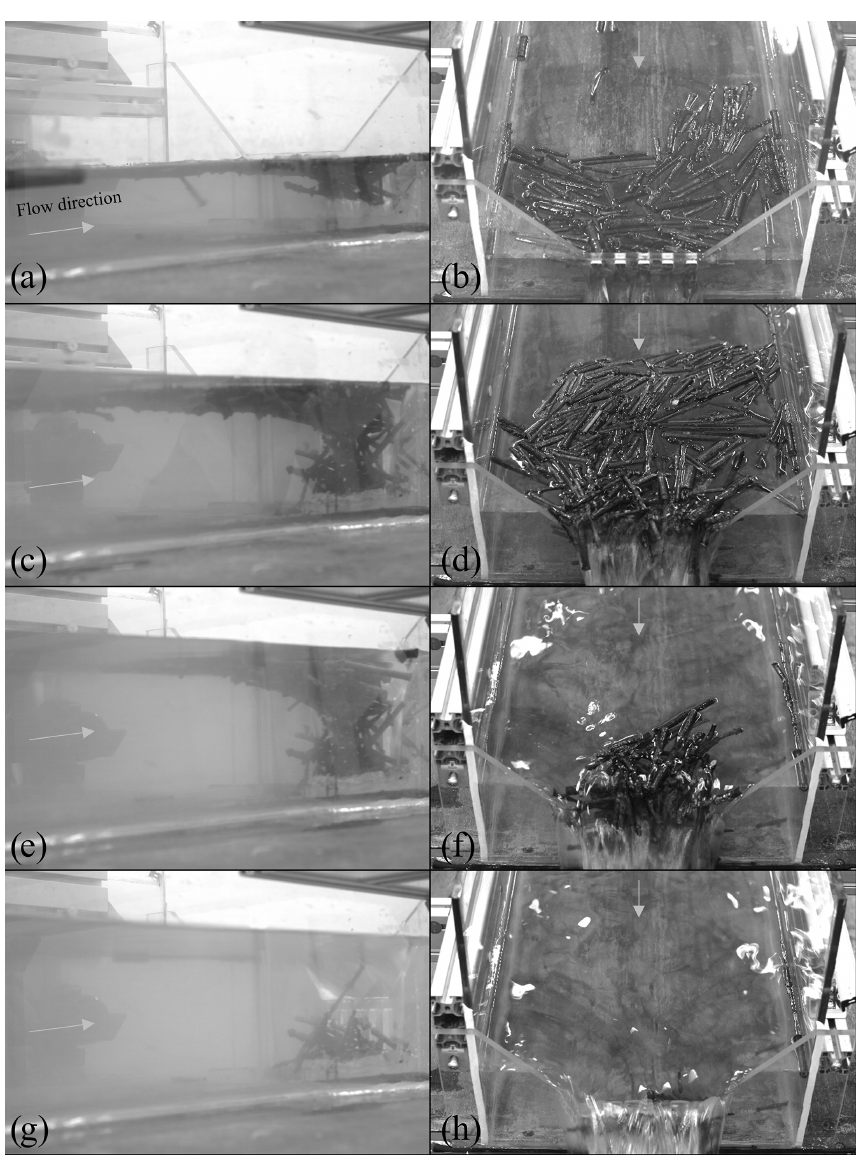
Figure 5. Example of phases observed during runs where overtopping occurred (illustrated here with Mix A2, repetition no. 2 on slot dam): Phase 1 – LW simply stuck at the dam, apart from a few floating LW pieces, here at discharge 0.5Ls − 1 , (a) side view and (b) top view; Phase 2 – slots jammed and floating carpet developed upstream, here at discharge 3.5Ls − 1 , (c) side view and (d) top view; Phase 2 later – denser jam for higher discharge (here at 5.4Ls − 1 ), several pieces already released, (e) side view and (f) top view, and 5s later the LW overtopped the barrier; and Phase 3 – final state after jam overtopping occurs here, still for discharge 5.4Ls − 1 , (g) side view and (h) top